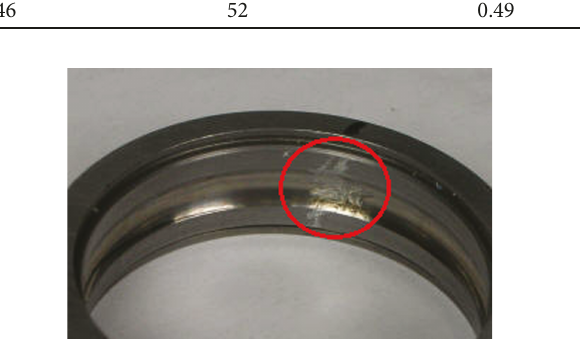
Figure 8: A photo of outer race fault. Table 3: Rolling element bearing